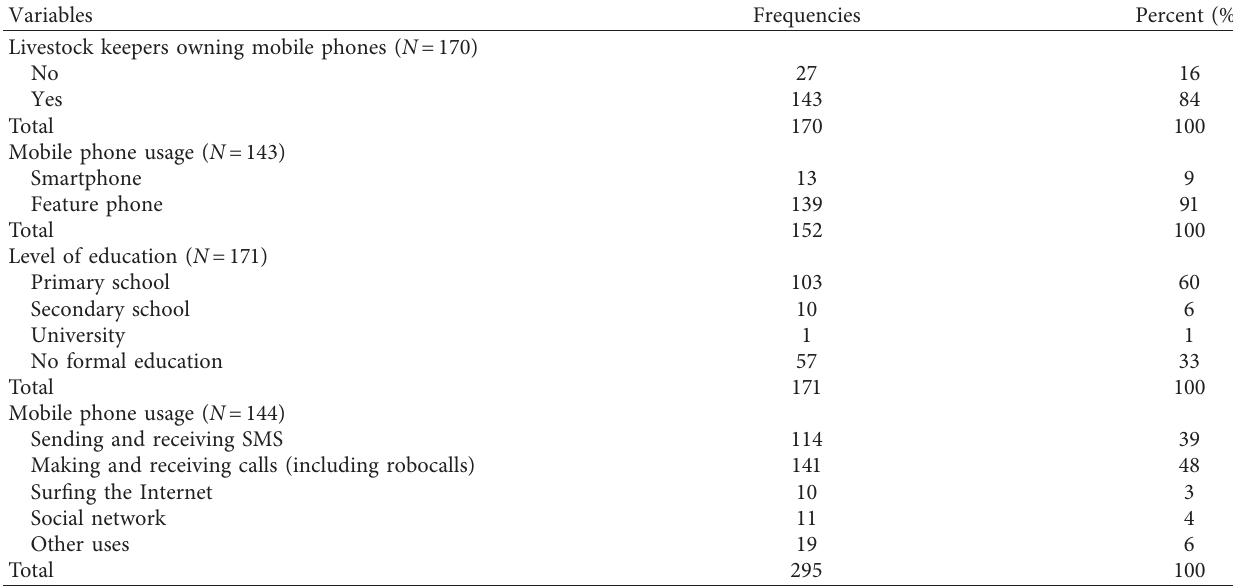
Table 2: Frequencies of livestock keepers’ demographic